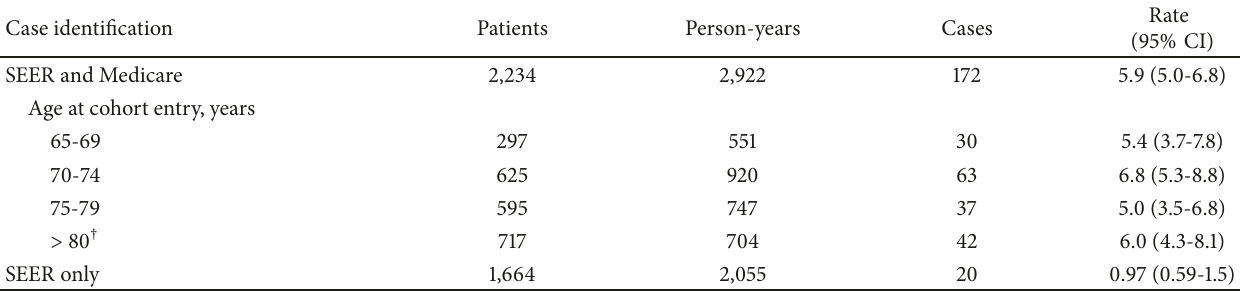
Table 5: Incidence rates of second primary cancer, per 100